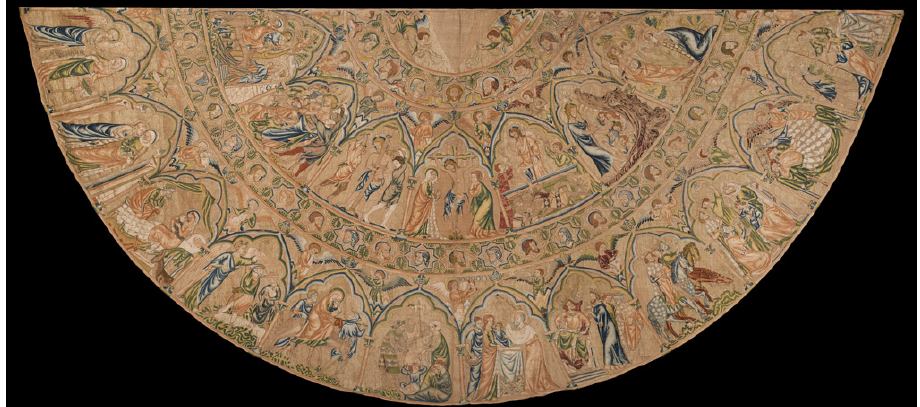
Figure 17. Bologna cope, late 13th to early 14th century. Bologna, Musei Civici d’Arte Antica, Italy. © Musei Civici d’Arte Antica di Bologna.